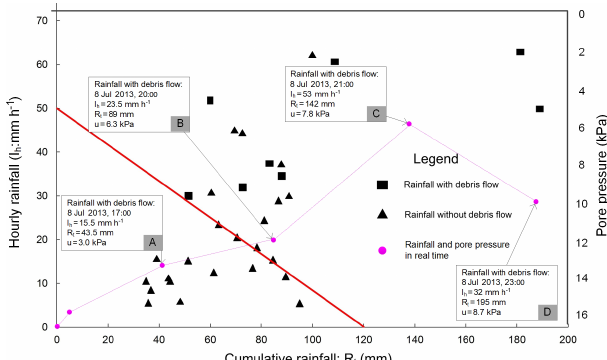
Figure 11. Case application of the presented method in Wenjia gully (8 July